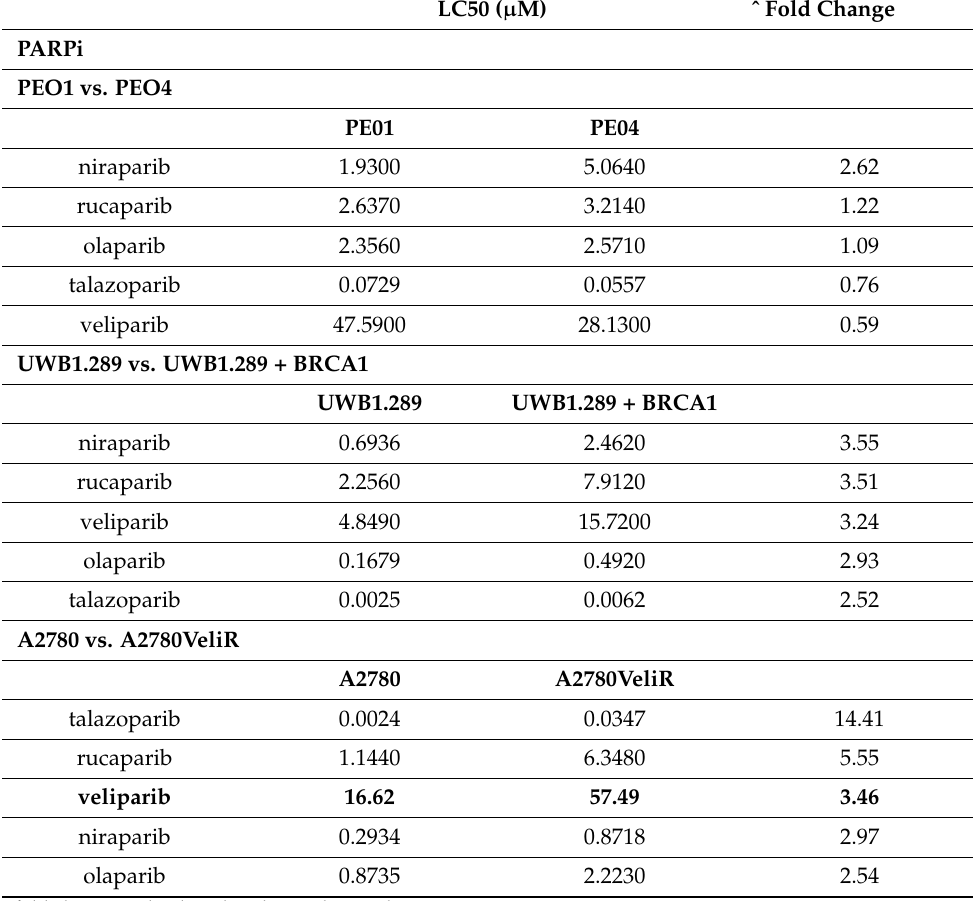
Table 1. LC50 comparisons (cell proliferation; MTS) for PARP is in BRCA1/2 –WT paired HGSOC cell lines and a parental–veliparib resistant endometrioid ovarian cancer cell